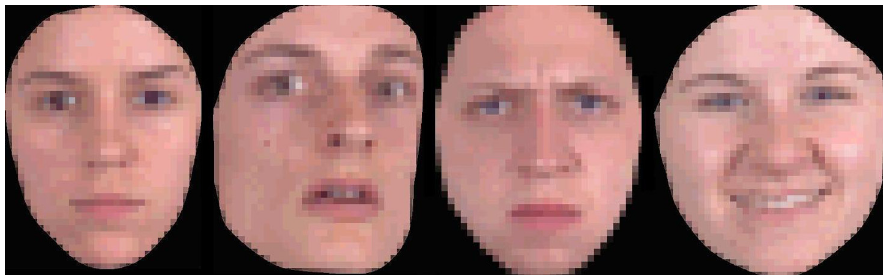
Fig 1. Example of degraded face stimuli (neutral; fearful; angry; happy, all 100% emotion intensity) used in the degraded facial affect labeling